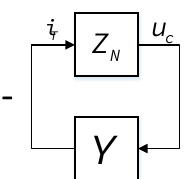
Figure 2. Feedback interconnection of Z N and Y .